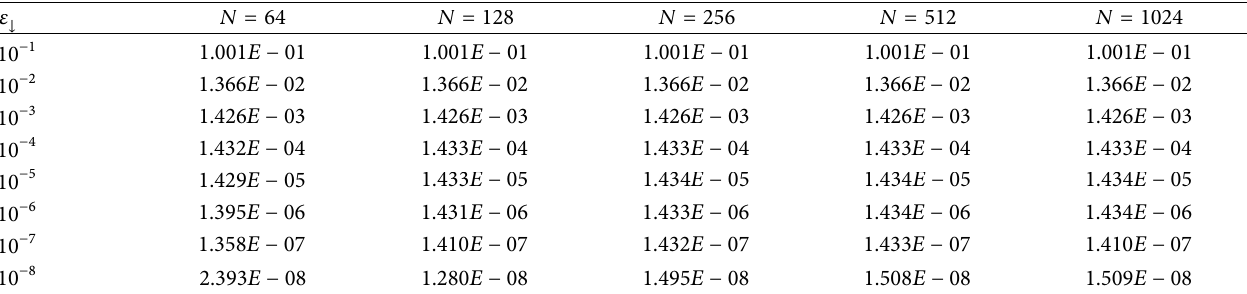
of Example 9. 𝑦 1